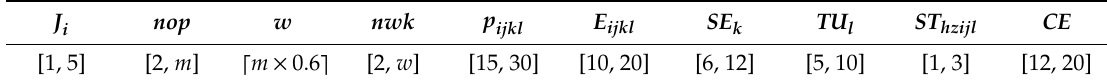
Table 1. Some parameters for the